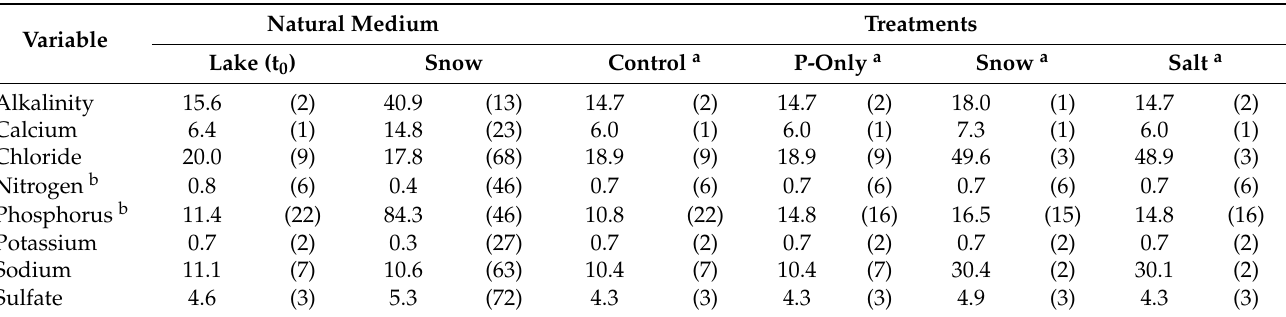
Table 2. Chemical composition of Lake Saint-Charles surface water (0–50 cm) in March 2016, and of the melted urban snow and experimental treatments. The values are the means for triplicate samples (SD as the percent mean in parentheses). Alkalinity is in mg CaCO 3 L − 1 , phosphorus is in µ g L − 1 and all other values are in mg L − 1